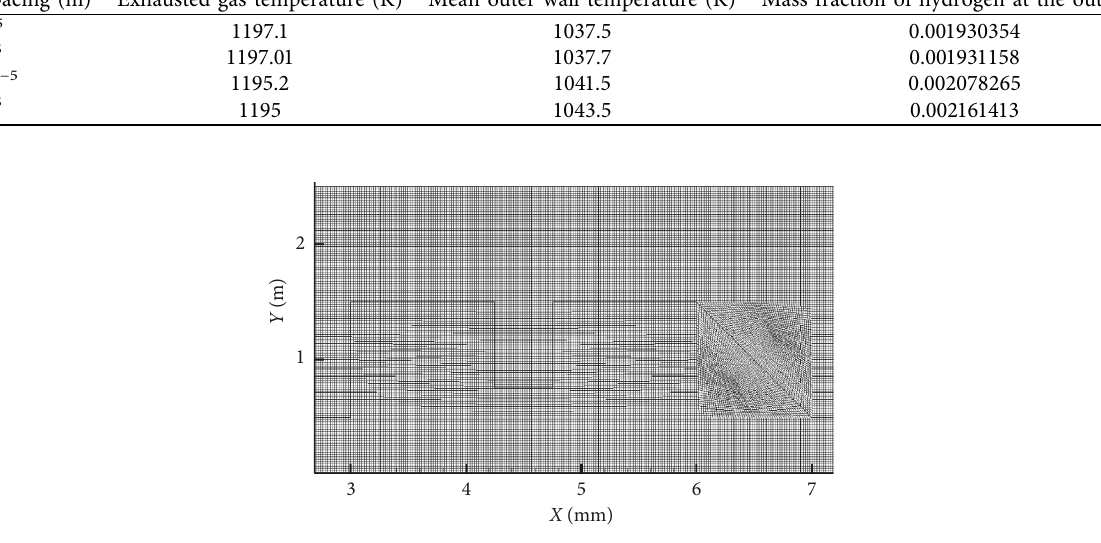
Figure 3: Demonstration of the grid system near the upper cavity.